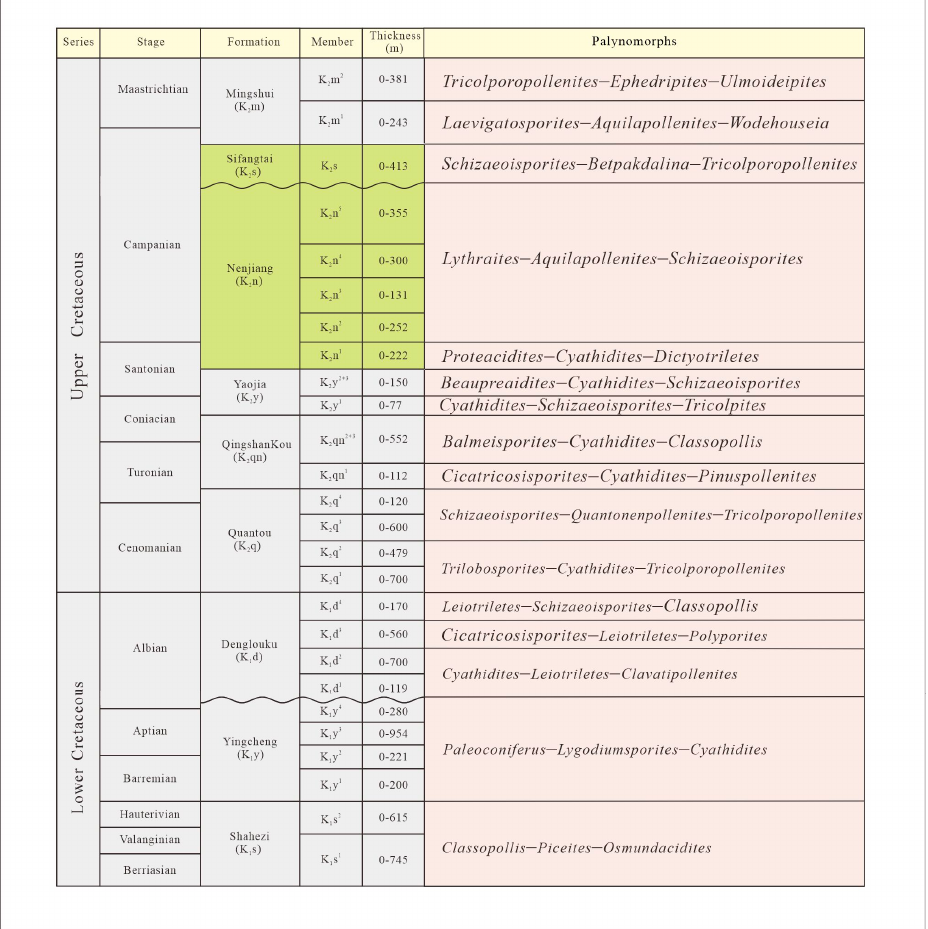
Figure 2. Cretaceous biozonation based on palynomorph assemblages in the Songliao Basin, accord- ing to [17].